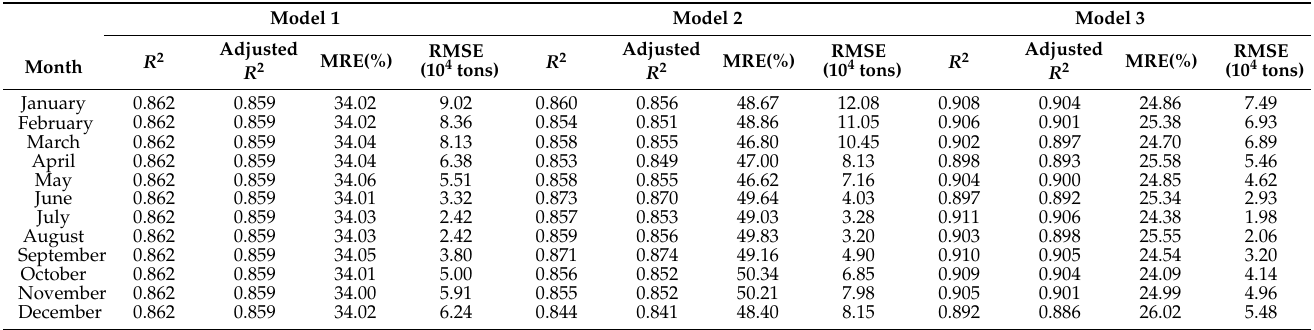
Table 1. Comparison of emission results from Models 1–3 in different